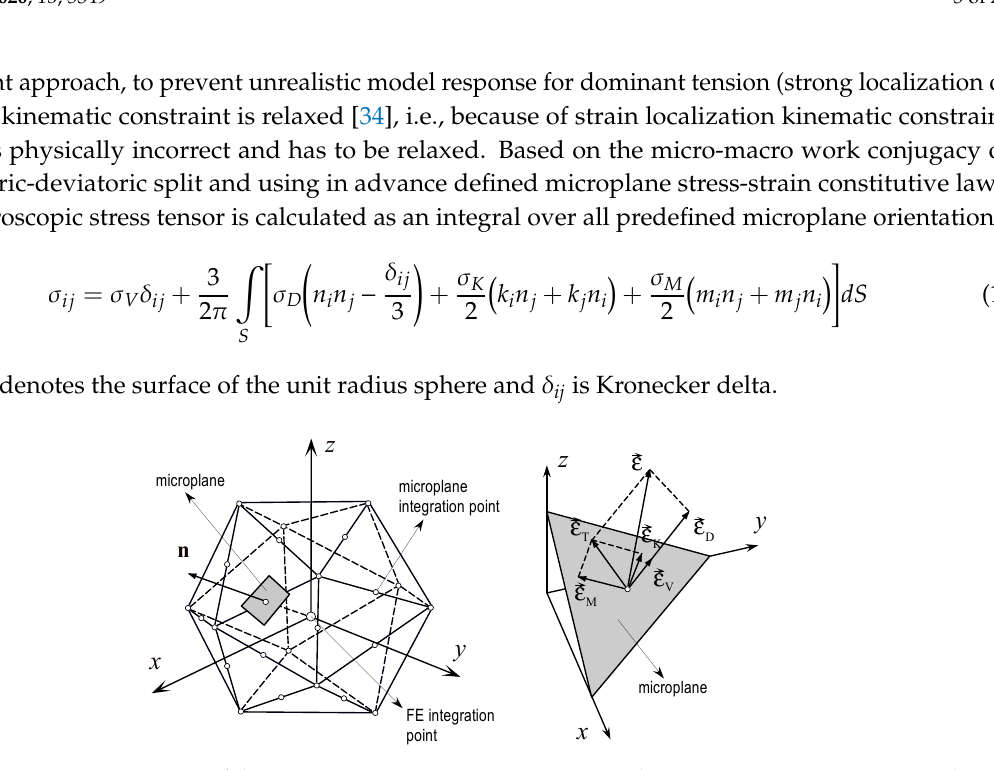
Figure 1. Decomposition of the macroscopic strain vector into microplane strain components—normal (volumetric and deviatoric) and shear.